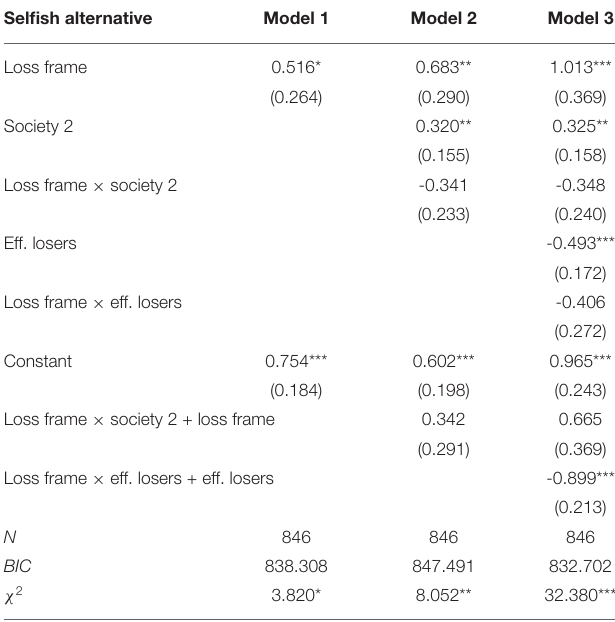
TABLE 3 | Random effect probit regressions on the probability of voting for the selfish alternative in plurality voting (PV).